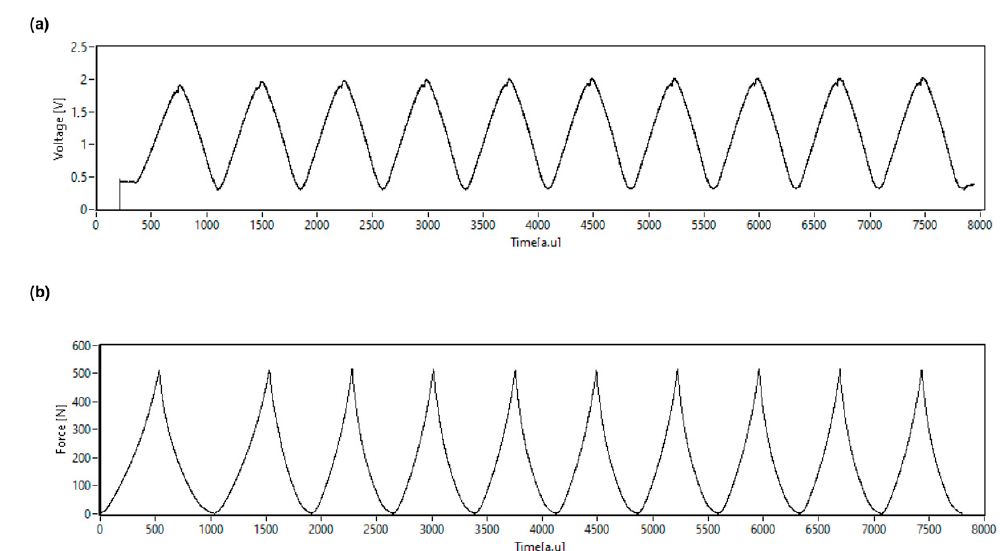
Figure 11. ( a ) the variation of voltage output with time for sample K.F + 10% GNPs; ( b ) the force variation over time for sample K.F +10% GNPs.